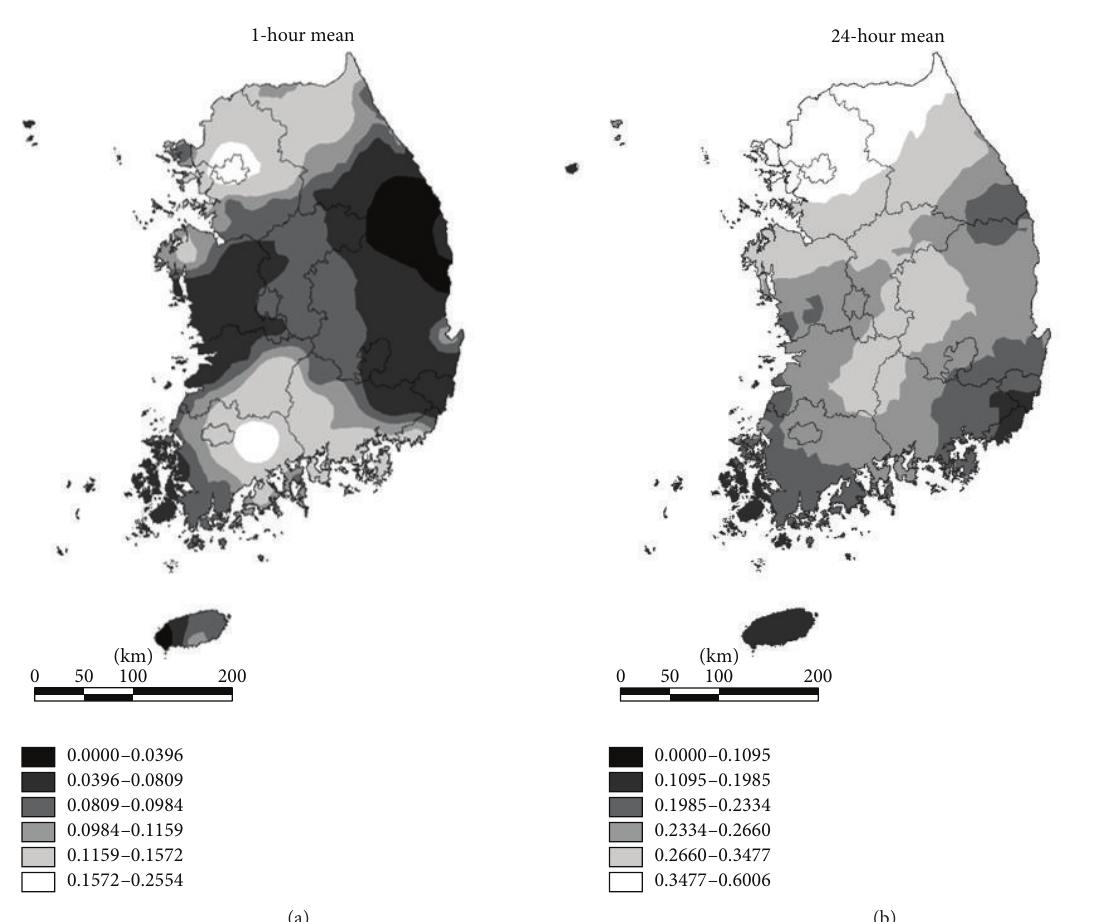
Figure 11: Map of the linear trend of (a) 1-hour and (b) 24-hour extreme